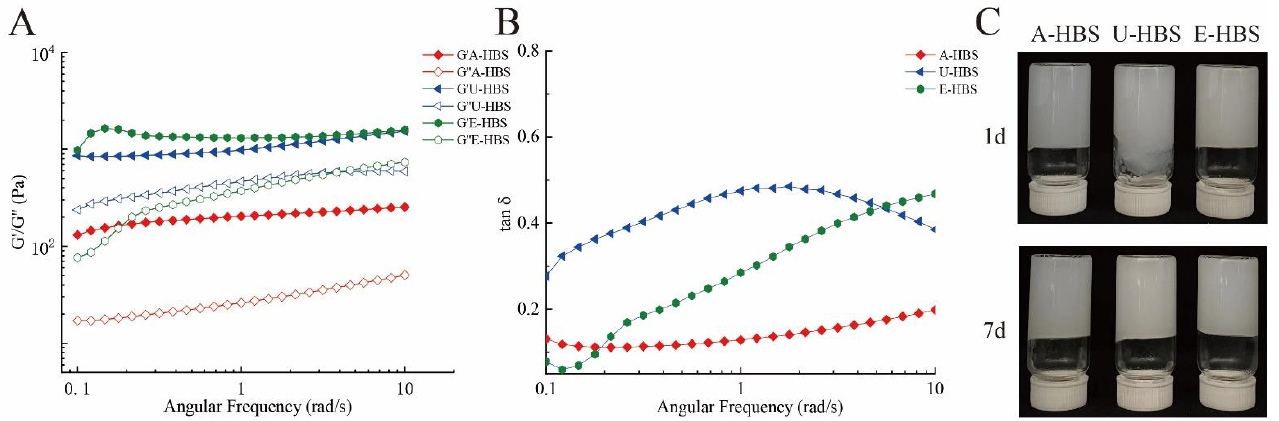
Figure 4. Rheological properties of highland barley starch samples: storage modulus (G ’ ), loss modulus (G ” ) ( A ); tan δ ( B ) and pictures of HBS gels stored for 1 and 7 days ( C ). A-HBS: HBS extracted by alkali method; U-HBS: HBS extracted by ultrasonic method; E-HBS: HBS extracted by enzymatic method.